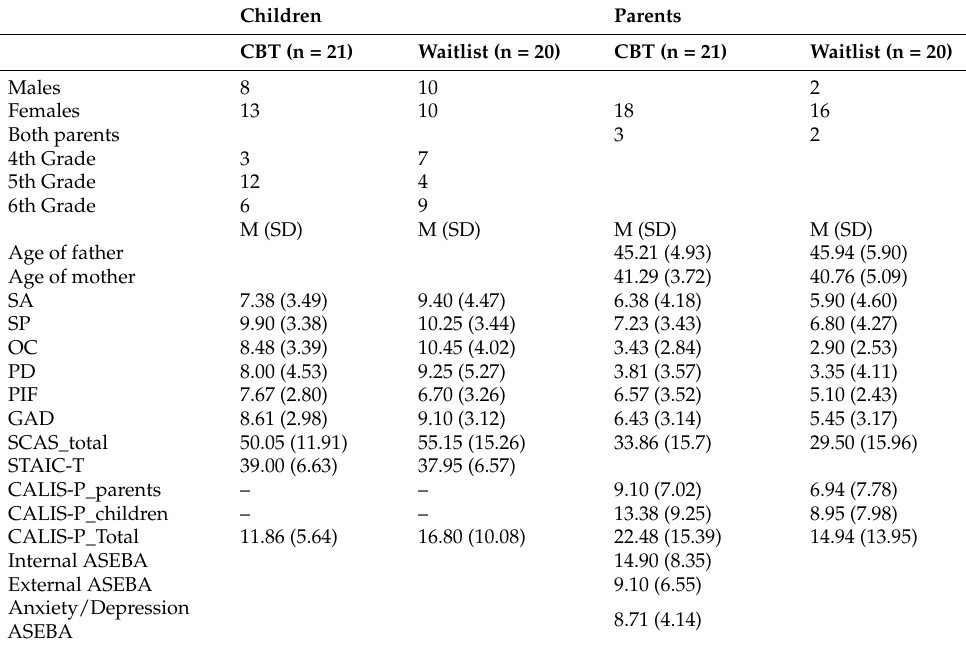
Table 1. Demographic and clinical reports/diagnostic